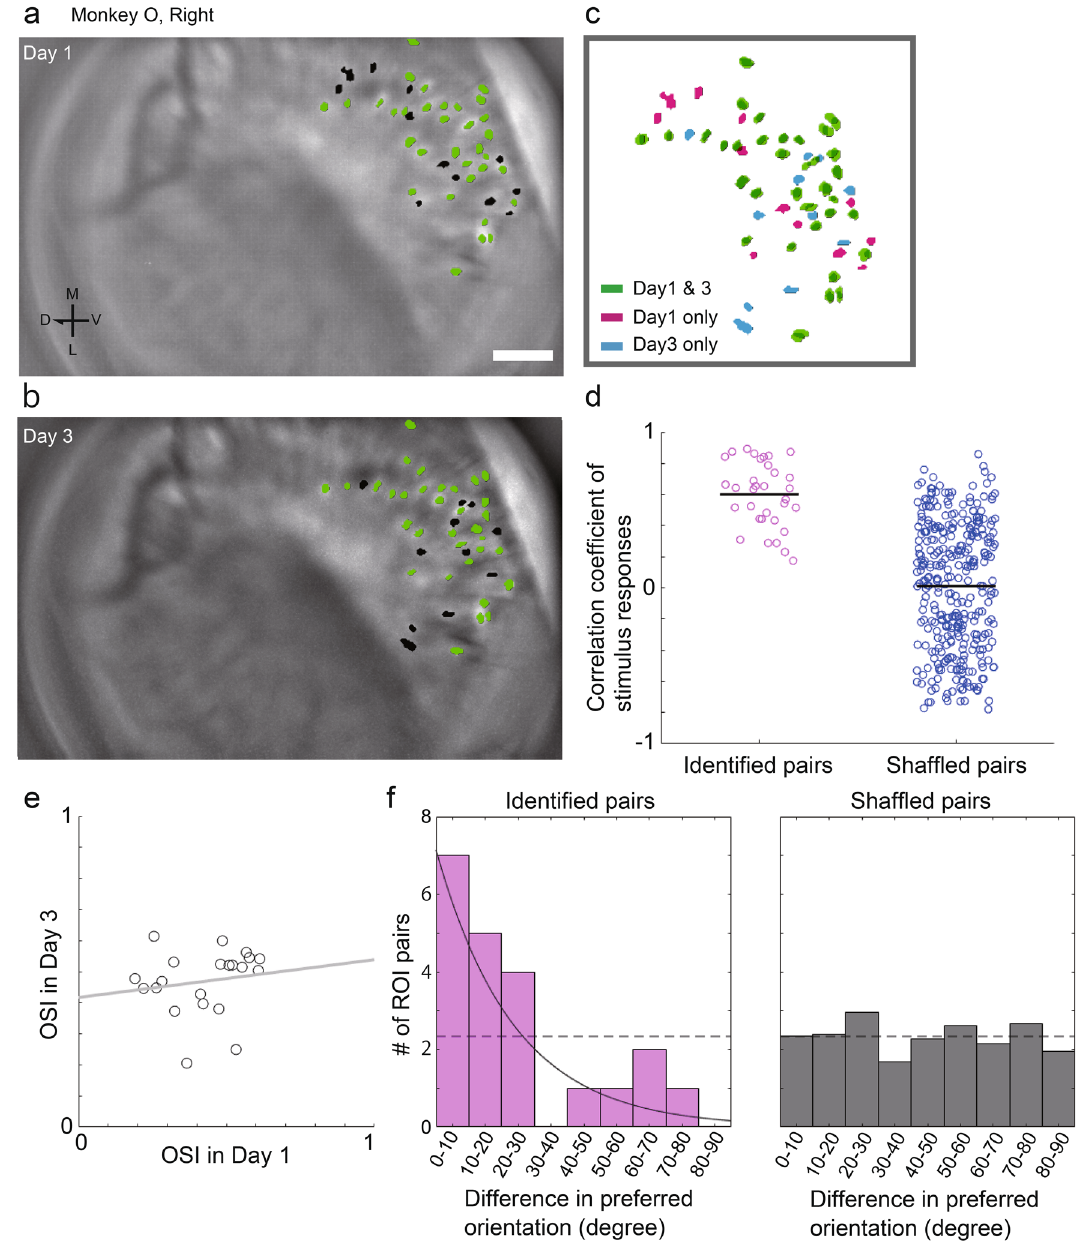
Figure 8. Cell tracing across days. ( a ) The same ROI distribution map with Fig. 5e. Green dots are identified as the same-colored dots in Day3. Black dots are ROIs that were not identified. ( b ) The ROI distribution map of Day3, which is two days after Day1. Green dots are identified as the same-colored dots in Day1. Black dots are ROIs that were not identified. Scale bar: 100 µm. ( c ) ROIs identified across days, only on Day1, and only on Day3 are shown in green, magenta, and cyan, respectively. ( d ) Correlation coefficients of fluorescence signals after stimulus presentation (0–2000 ms) between ROI pairs identified on Days 1 and 3 averaged over different orientations. The magenta dots represent identified pairs, and the blue dots represent shuffled pairs. ( e ) Scatter plot of OSI on Day1 and Day3 for identified pairs. The dots represent each identified ROI. ( f ) Histogram of the absolute values of the difference in preferred orientation between ROI pairs identified on Days 1 and 3. Zero means that the ROI showed the same value of preferred orientation on both days. The magenta bars in the left panel are the actual observed data, and the gray bars in the right panel are the shuffled data. The horizontal dashed line represents the chance level. The solid line represents the exponential curve fitted to the observed data. V, ventral; D, dorsal; M, medial; L,